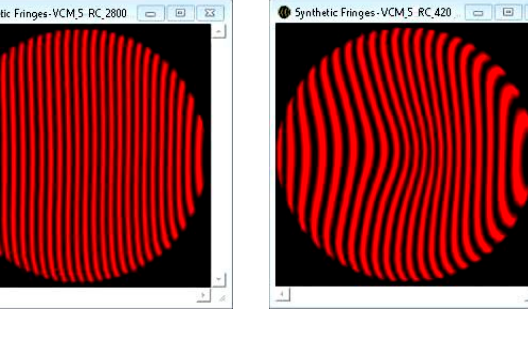
Figure 18. Surface plot ( left ) and aberration table ( right ) of VCM#5 at full clear aperture 14 mm for the maximum curvature deformation at f /5, corresponding to a curvature radius 140 mm.